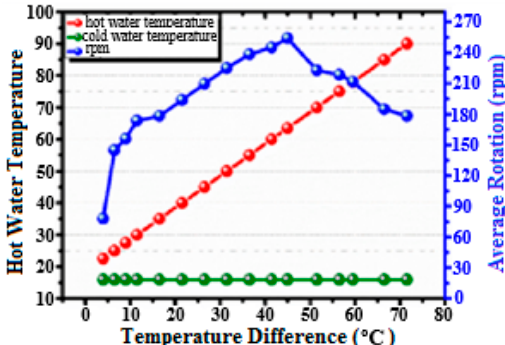
Figure 7. Temperature difference between hot and cold water jets vs. the rotational speed (rpm) of the thermomagnetic engine.